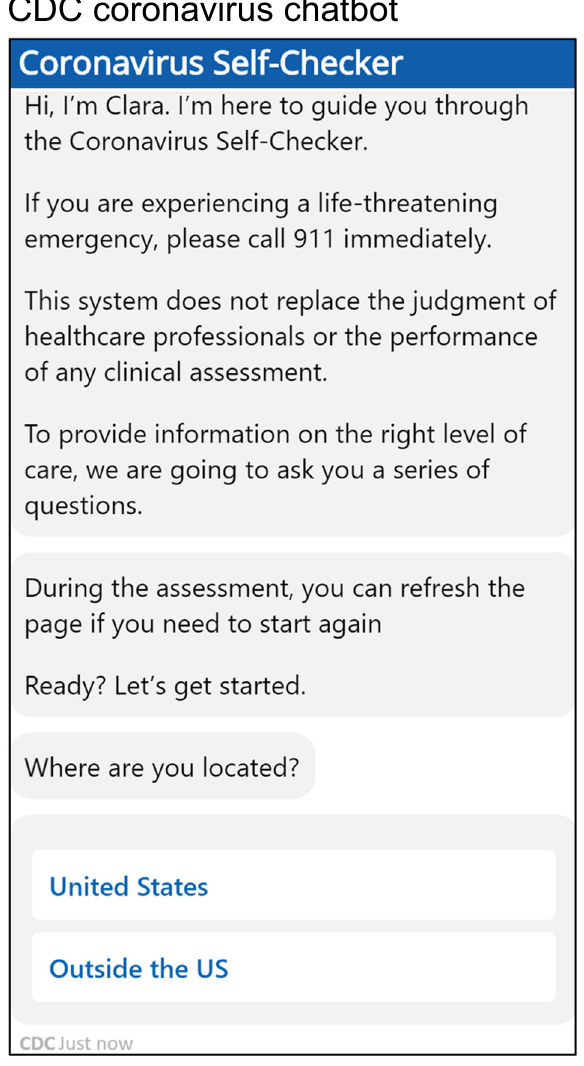
Fig. 1 Coronavirus chatbot user interface. Chatbot publicly available at Centers for Disease Control and Prevention (CDC) website: https://www.cdc.gov/coronavirus/2019-ncov/symptoms- testing/testing.html (Captured 13 Apr